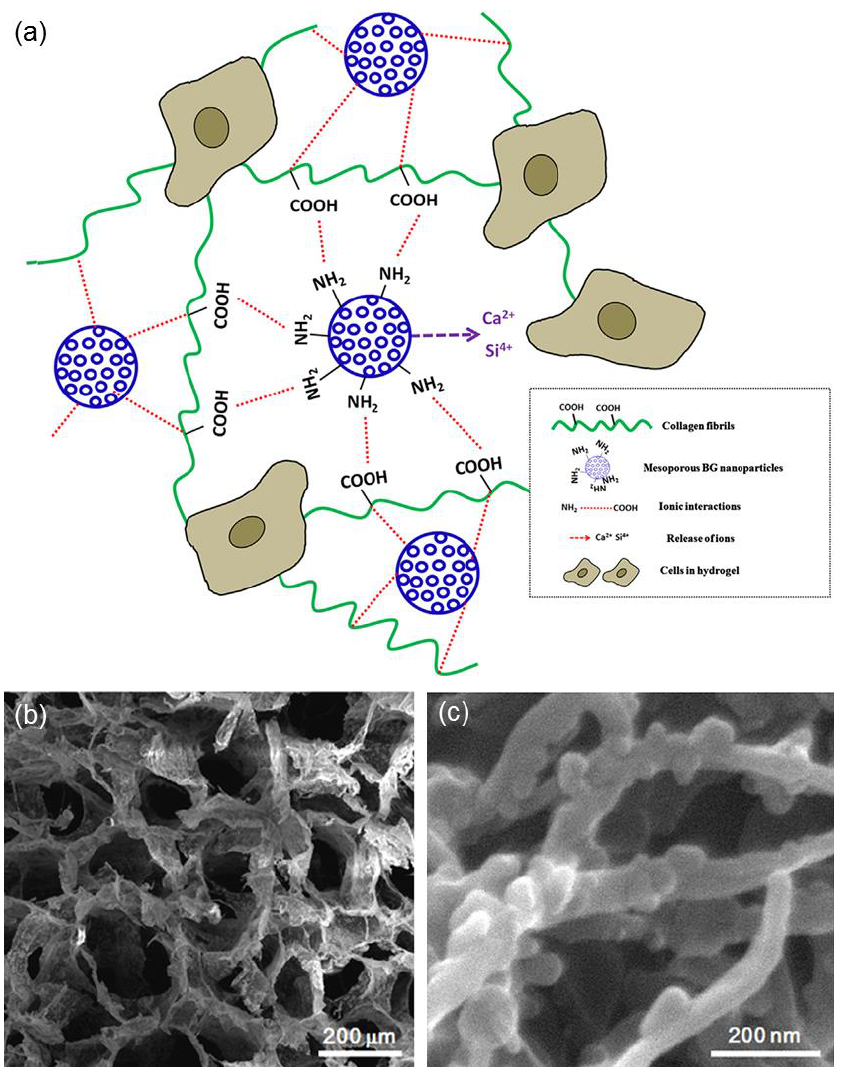
Figure 2. MBG/collagen nanocomposite obtained by freeze-frying: ( a ) schematic illustration of the material structure and function (ion release from MBG nanoparticles is expected to promote bioactivity and cellular mineralization, and the surface functionalization of MBG with amino groups facilitates chemical links with amino-acid sequences of collagen molecules, which enables the physico-chemical stability of the hydrogels); ( b ) scanning electron microscopy (SEM) micrograph of the hydrogel structure; and ( c ) detail showing the collagen fibrils integrated with MBG nanoparticles. Images adapted from El-Fiqi et al. [17] © Elsevier.